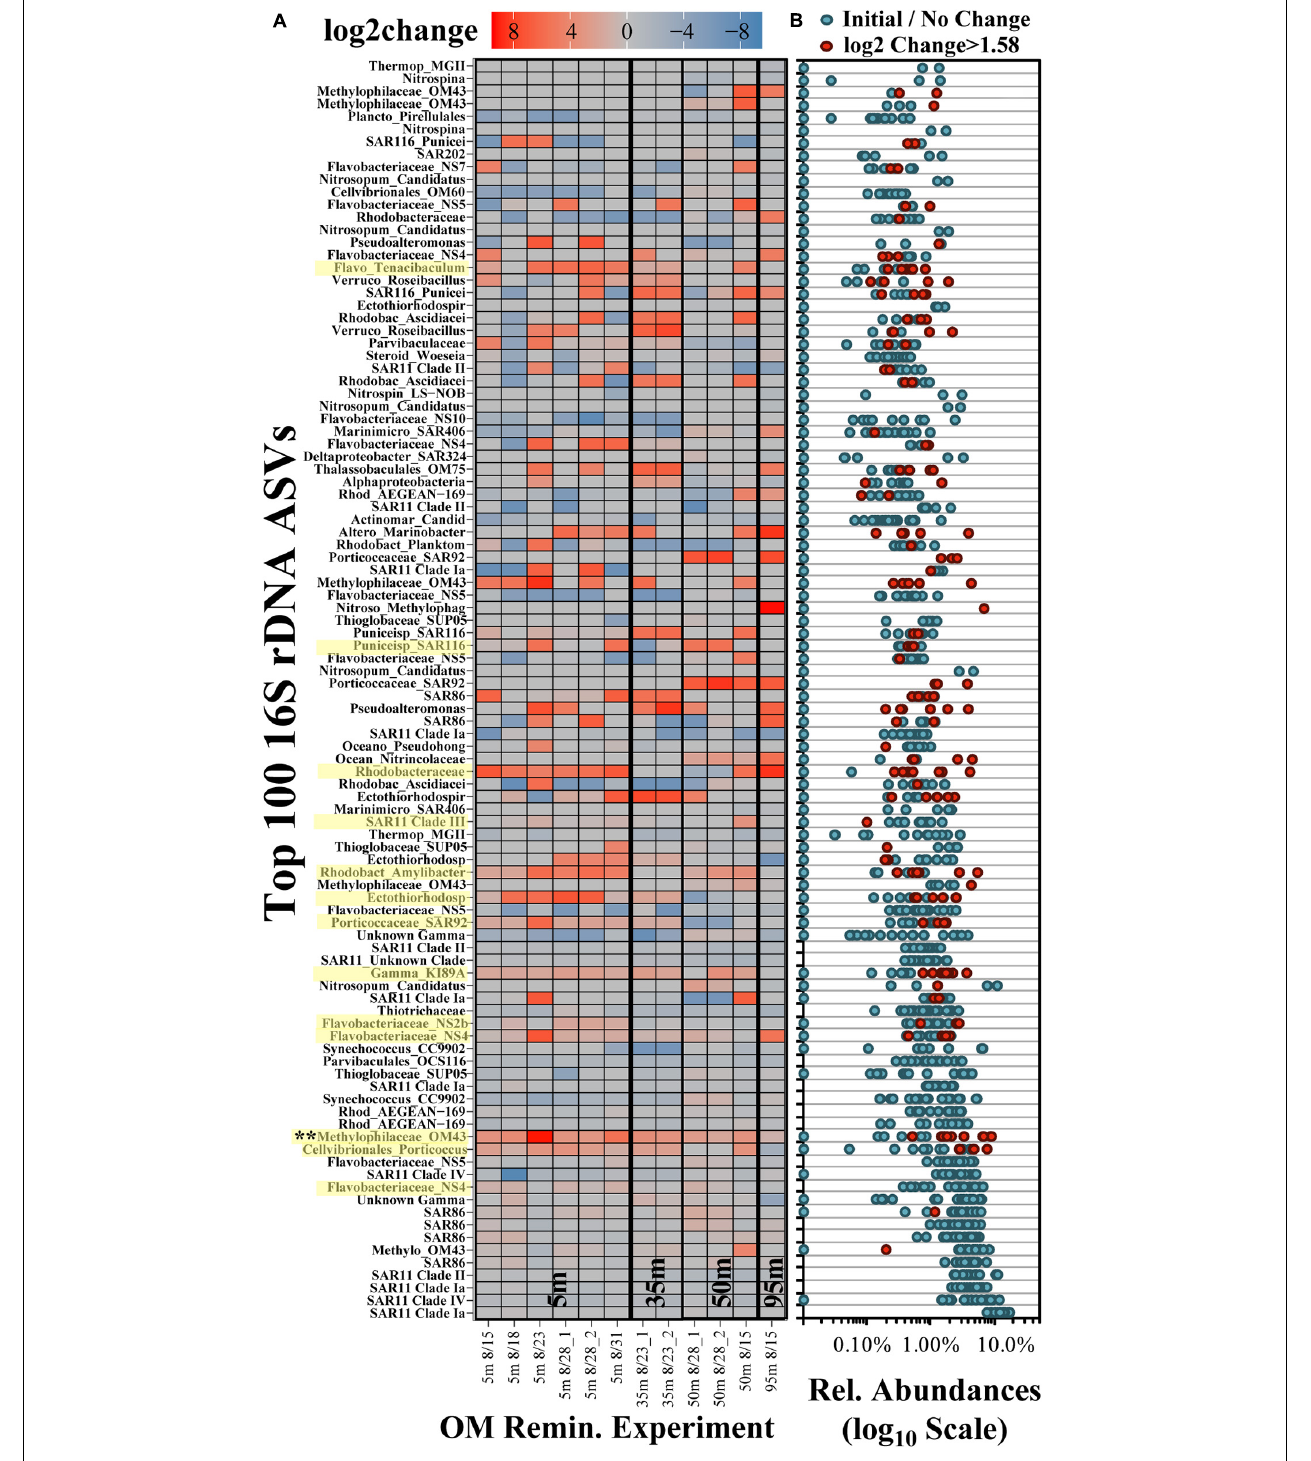
FIGURE 6 | Log2-fold change heatmap of the 100 most frequent ASVs in the OM remineralization experiments (A) and the associated relative abundances (B) . The x -axis in (A) refers to the date of experiment initiation and the appended number in the sample names refers to duplicate treatment values, where available. ASVs highlighted in yellow on the y -axis identify those that were significantly ( p < 0.05) elevated and determined to be indicators in surface experiments (De Cáceres and Legendre, 2009). Each dot in (B) represents the abundances associated with the samples presented in (A) ; red dots identify ASVs with log2-fold change > 1.58 (equivalent to a threefold difference) and blue dots refer to all other